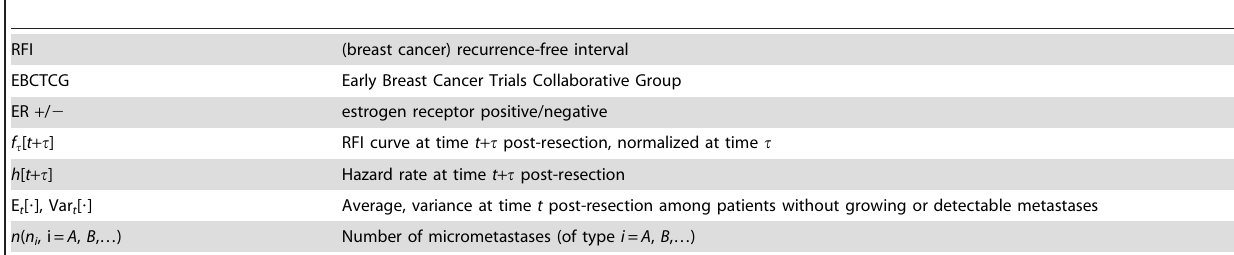
Table 1. Abbreviations and